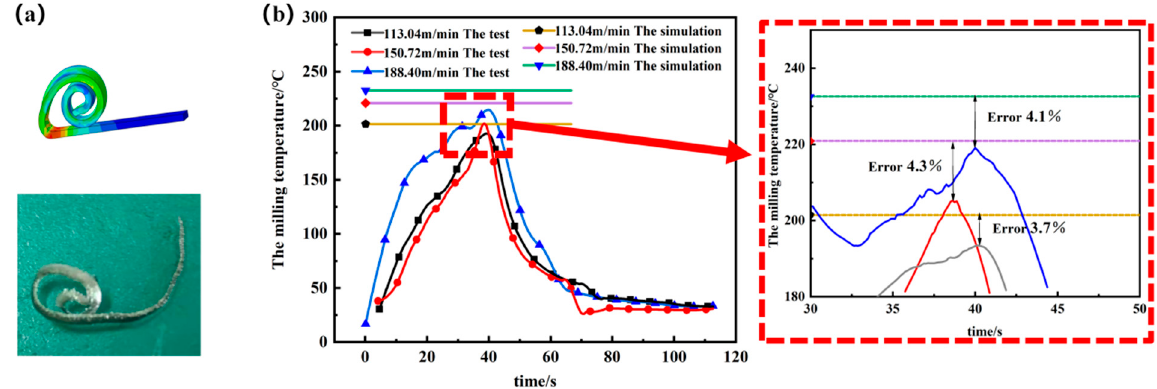
Figure 13. ( a ) Comparison of the milled and simulated chip shapes. ( b ) Milling test temperature and the simulation maximum point comparison.